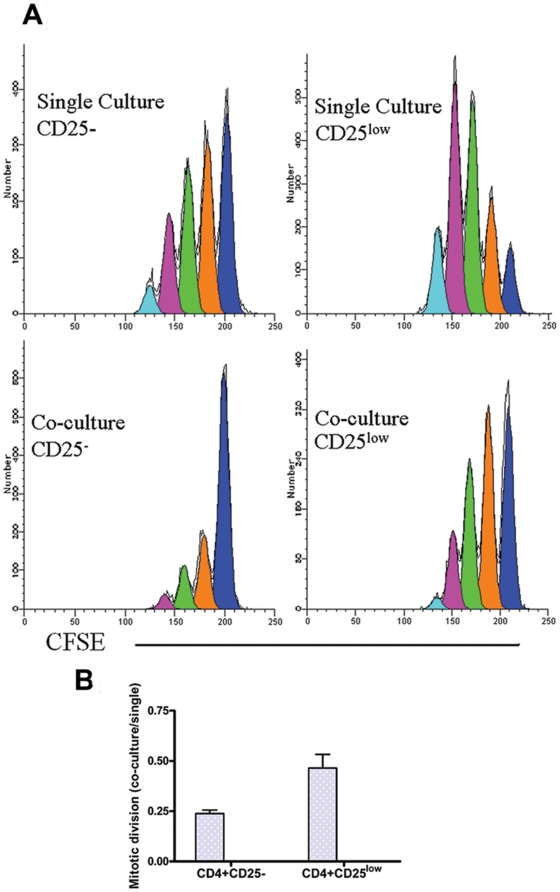
CD4+CD25low responder T cells proliferate faster and are harder to suppress.A) CFSE-labeled responder T cells were cultured for 3 days with 1 µg/ml anti-human CD3-coated beads and 1x irradiated PBMC either in the presence or absence of an equal number of Tregs. Each color represents a particular cell generation. Blue color (first peak from right on all four histograms) presents undivided cells. Orange color presents cells that divided once, green peak cells that divided twice, purple color cells that divided three times and light blue presents cells that divided four times. This is representative of three independent experiments. B) The ratio of the normalized mean number of division in co-culture/single culture was calculated using the software ModFit and method of De Boer and Perelson (see Statistical analysis). The average ratio of mitotic divisions for three samples in co-culture versus single culture is 0.23±0.05 for CD4+CD25- T cells and 0.46±0.06 for CD4+CD25low T cells (p<0.05, n = 3).